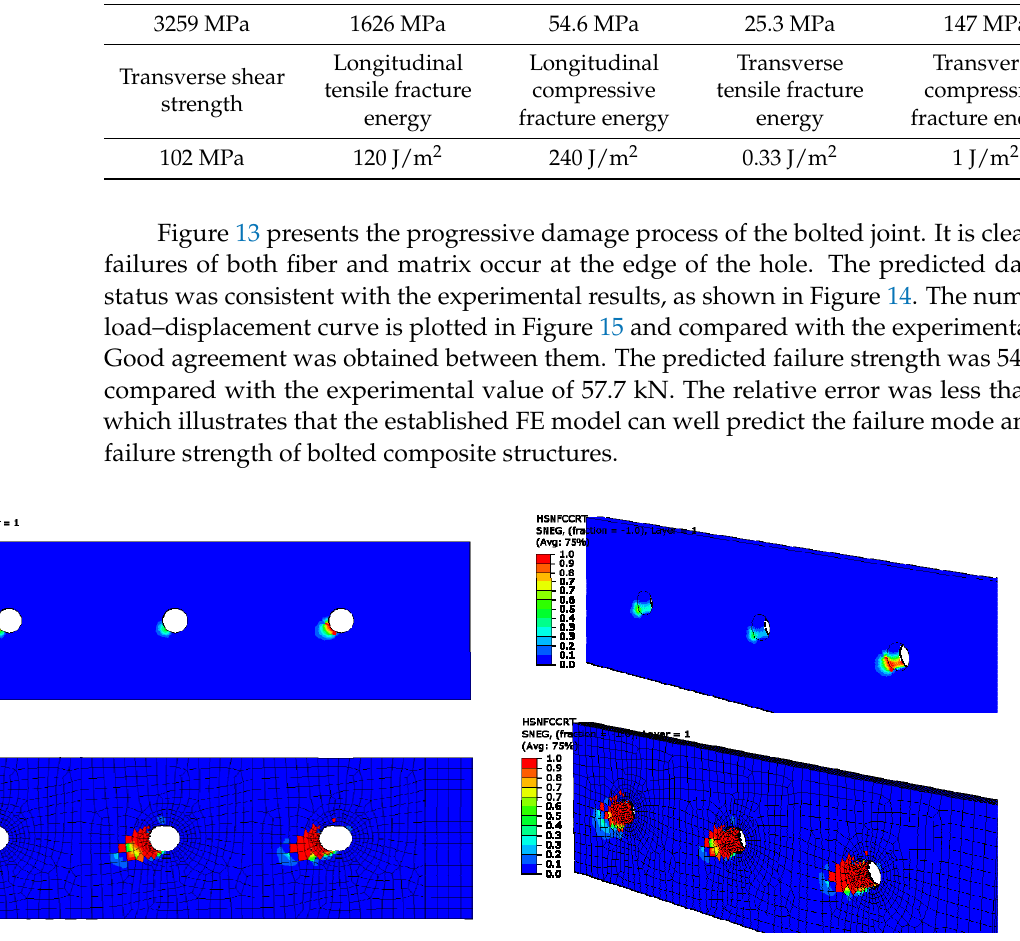
Figure 13. Predicted failure process of the bolted joint.